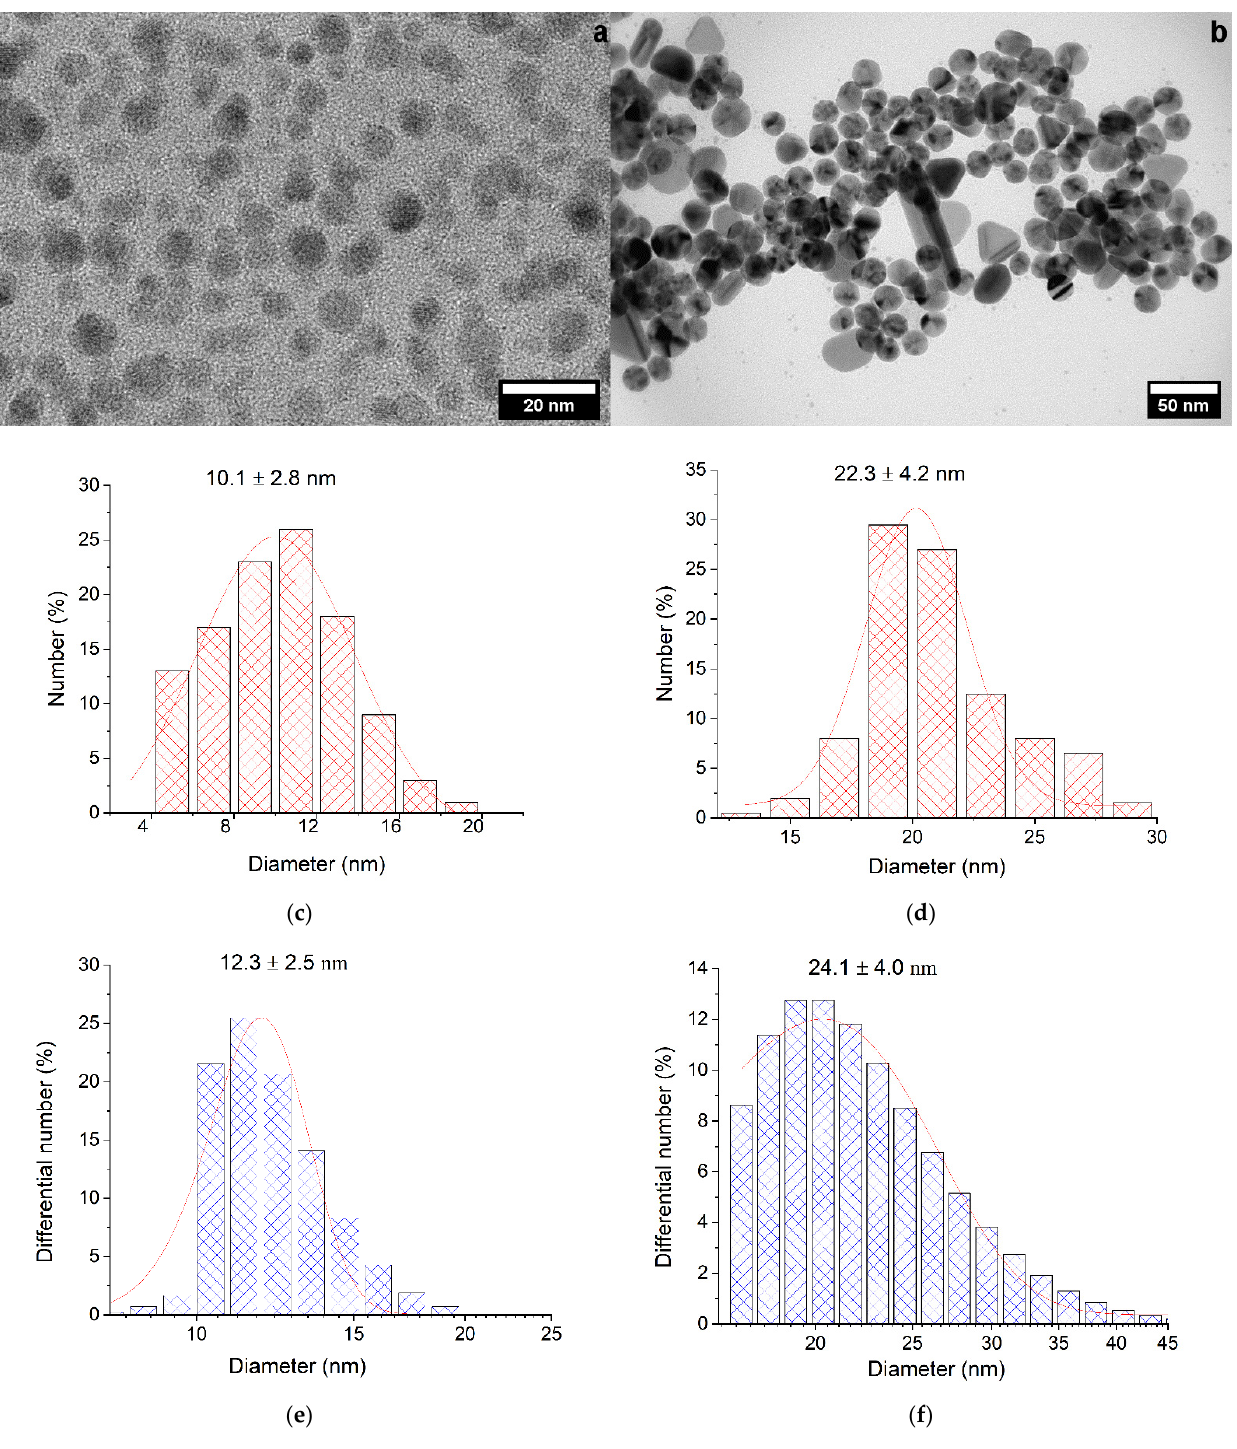
Figure 1. TEM and DLS images of silver nanoparticles and particle-size-distribution histograms. Solution: [Ag + ] = 3 × 10 − 4 mol L − 1 ; [C 2 O 42 − ] = 5 × 10 − 4 mol L − 1 ; ( a , c , e ) deaerated; ( b , d , f ) in air. pH = 7.0 ± 0.1. According to electron diffraction analysis, the nanoparticles had a polycrystalline structure. The electron diffraction pattern of the nanoparticles obtained in air showed